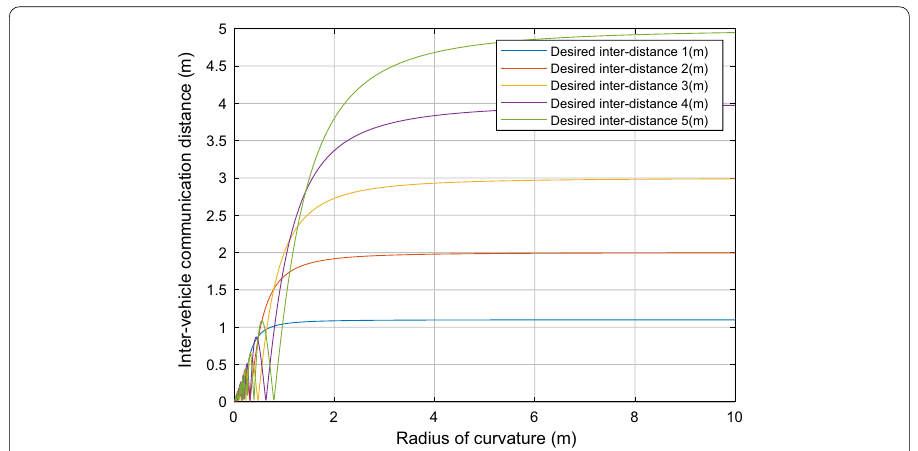
Fig. 8 Inter-vehicle communication distance under two-dimensional space